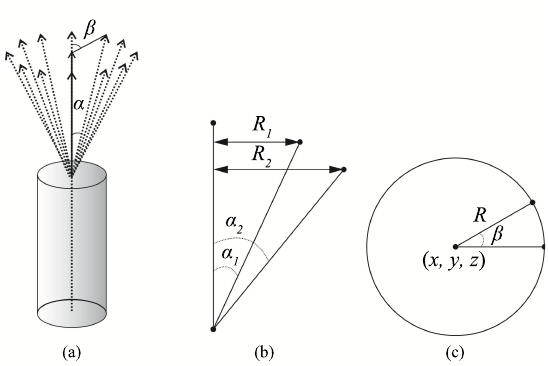
Figure 8. Cylinder growing strategy. The cylinder is shifted ( a ); vertically tilted ( b ); and horizontally rotated ( c ).